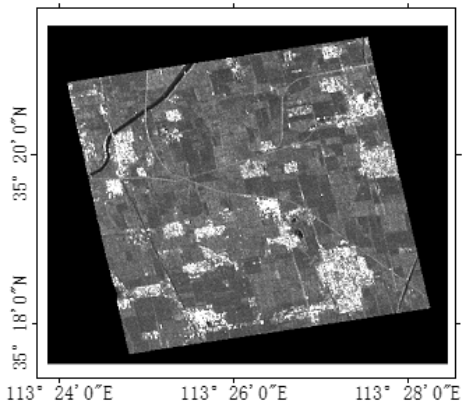
Figure 1. Experimental area SAR intensity map